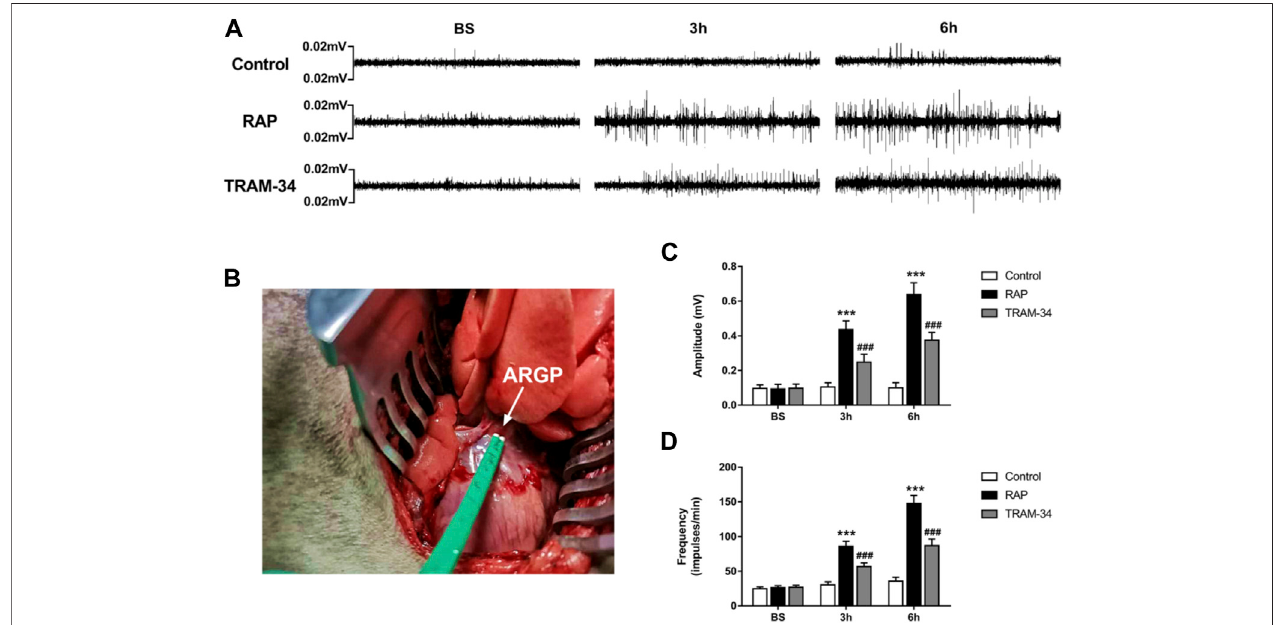
FIGURE 2| ARGP activity at baselineand after rapid atrial pacing in the three groups. (A) ARGP activity at baseline, after 3 h, and after 6 h in the three groups; (B) : Microelectrodes were inserted into the ARGP; (C,D) The frequency and the amplitude of ARGP in the three groups. The frequency and amplitude of ARGP activity was increased after rapid atrial pacing. TRAM-34 injection inhibited the increased ARGP activity. *** p < 0.01vs the control group and TRAM-34 group; ### p < 0.01vs the control